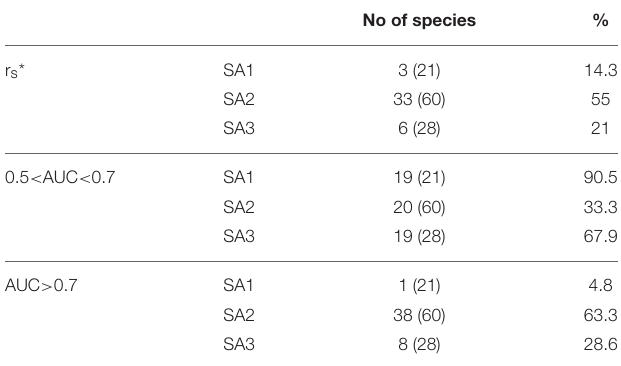
TABLE 3 | Summary of the predictive performance of the Species Archetype Models, evaluated by species and expressed as the number and the percentage of species with r s : Spearman’s rank correlation coefficient, where * denotes significant values at the p < 0.05 level and AUC: Area Under the ROC Curve (numbers in parentheses are total number of species for each